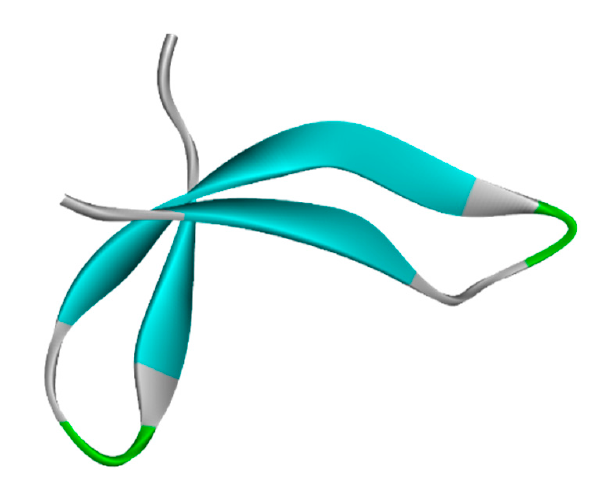
Figure 1. BCR-ABL1 fusion protein 3D structure from AlphaFold.